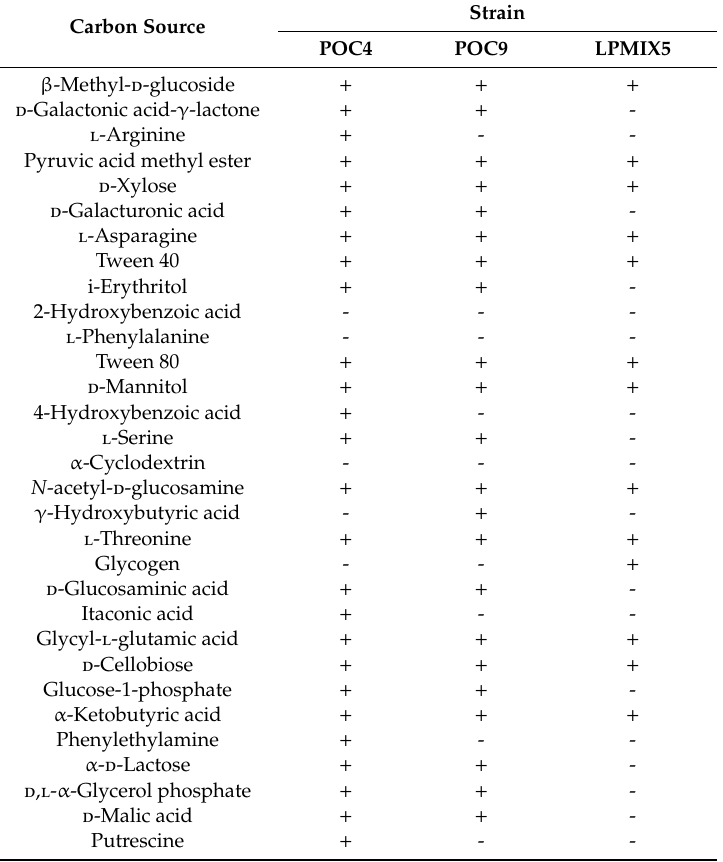
Table 2. Results of the phenomic